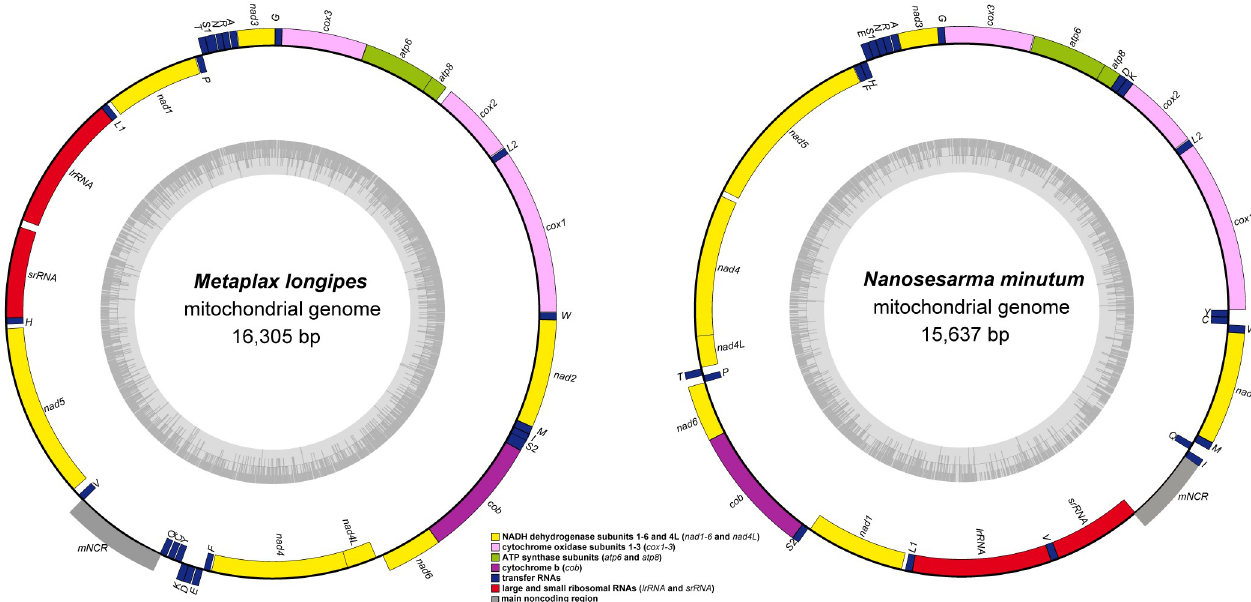
Fig 2. Mitogenomic maps of Metaplax longipes and Nanosesarma minutum . Genes are color-coded, i.e., cytochrome oxidase subunits 1–3 ( cox1 - 3 ): pink, NADH dehydrogenase subunits 1–6 and 4L ( nad1 - 6 and nad4L ): yellow, ATP synthase subunits ( atp6 and atp8 ): green, cytochrome b ( cob ): purple, large and small ribosomal RNAs ( lrRNA and srRNA ): red, transfer RNA genes (tRNA): blue, and the main noncoding region (mNCR): gray. Each tRNA gene is designated by a single-letter amino acid code except for L1 (trnLeu (CUN)), L2 (trnLeu (UUR)), S1 (trnSer (AGN)), and S2 (trnSer (UCN)).